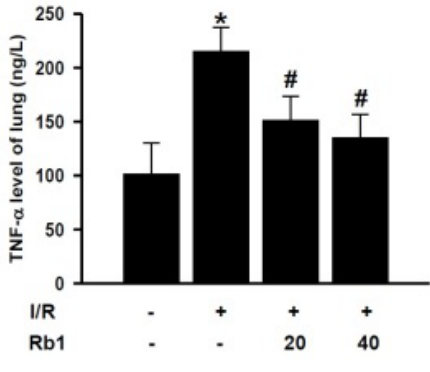
Figure 6. Effects of Rb1 on TNF- α levels of